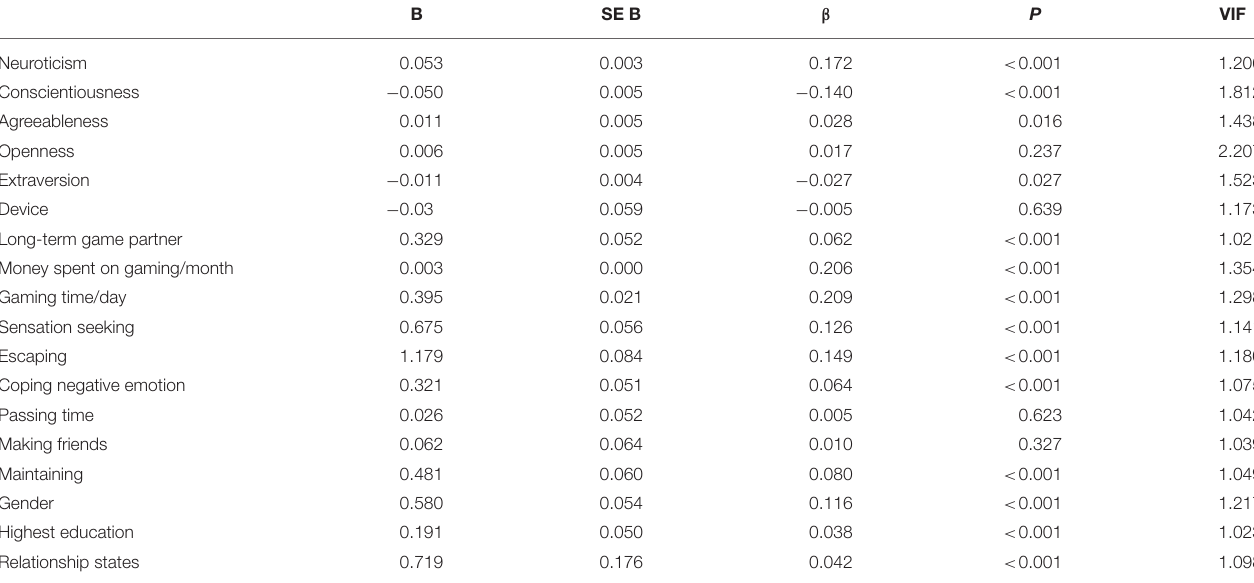
TABLE 2 | Multivariable linear regression of factors associated with